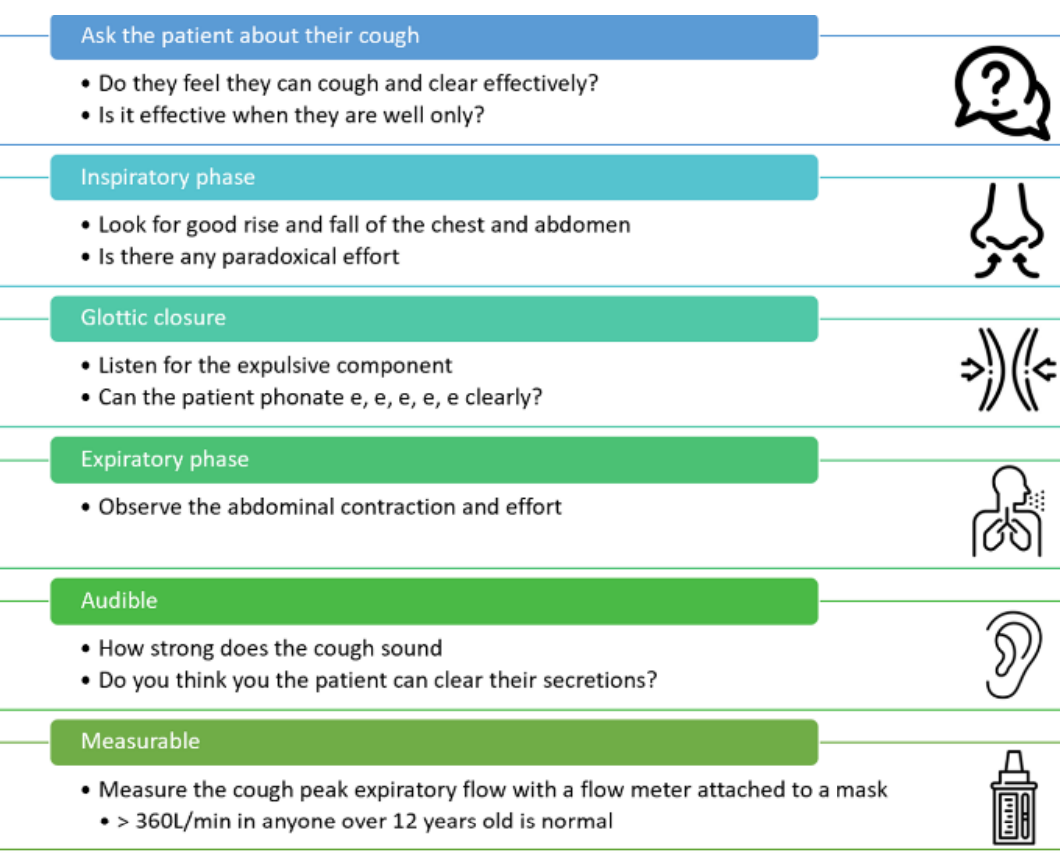
Figure 2. Shows one approach to assessing the efficacy of a patient’s